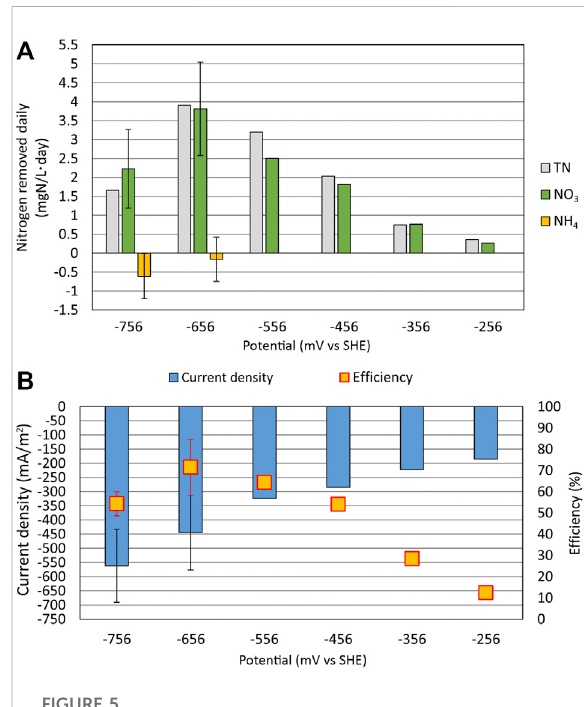
FIGURE 5 Relationship between the electrode potential (mV vs. standard hydrogen electrode), nitrogen removal rate, and current density. (A) Daily removal rate for total nitrogen (TN), nitrate (NO 3 ), andammonium (NH 4 )ondifferentWEpotentials. (B) Faradaic ef fi ciencywiththeaveragecurrentdensityisshownatdifferentWE potentials. At the WE potential of − 756 mV, there are three parallel measurements, and at − 656 mV, there are two parallel measurements for NO 3 and NH 4 . Error bars represent standard deviations.